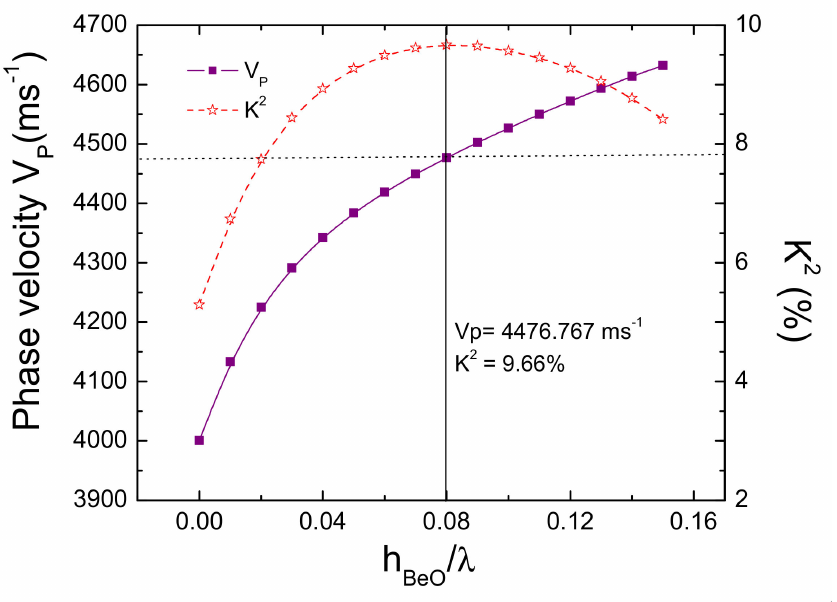
(cid:0) (cid:1) K 2 with